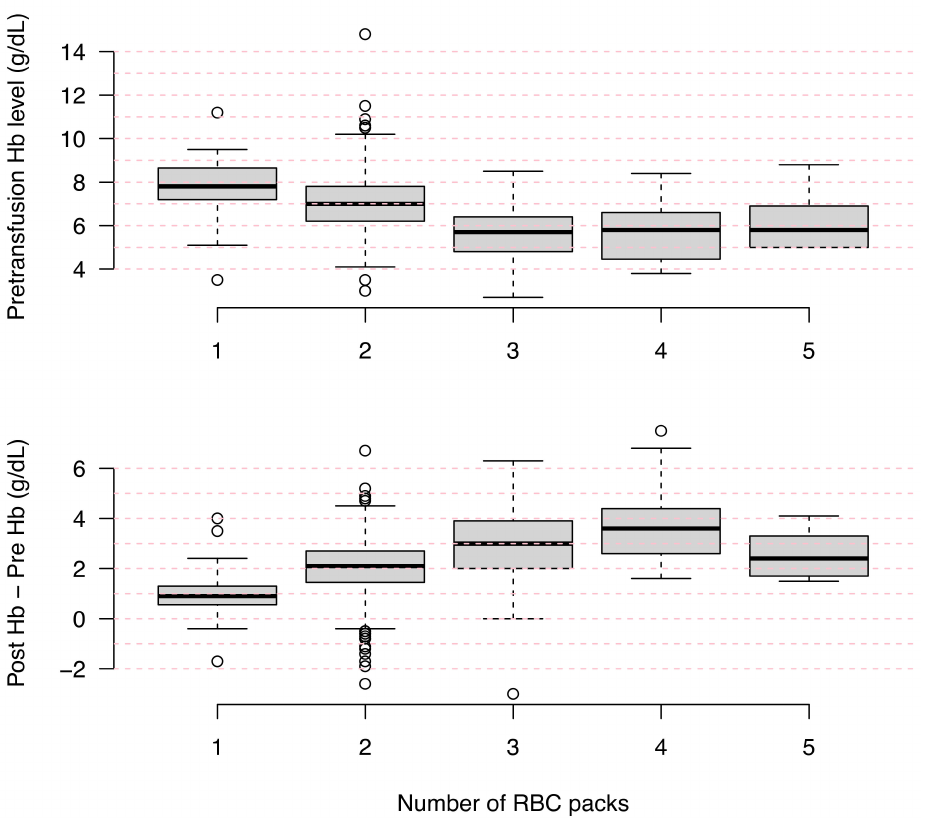
Figure 5. Boxplots of the pretransfusion Hb level and the Hb difference before and after transfusion depending on the number of transfused red blood cell packs in the ED ( N = 512). Table 3. Characteristics of patients that were overtransfused with red blood cells (post-transfusion Hb level ≥ 10 gr/dL) in the